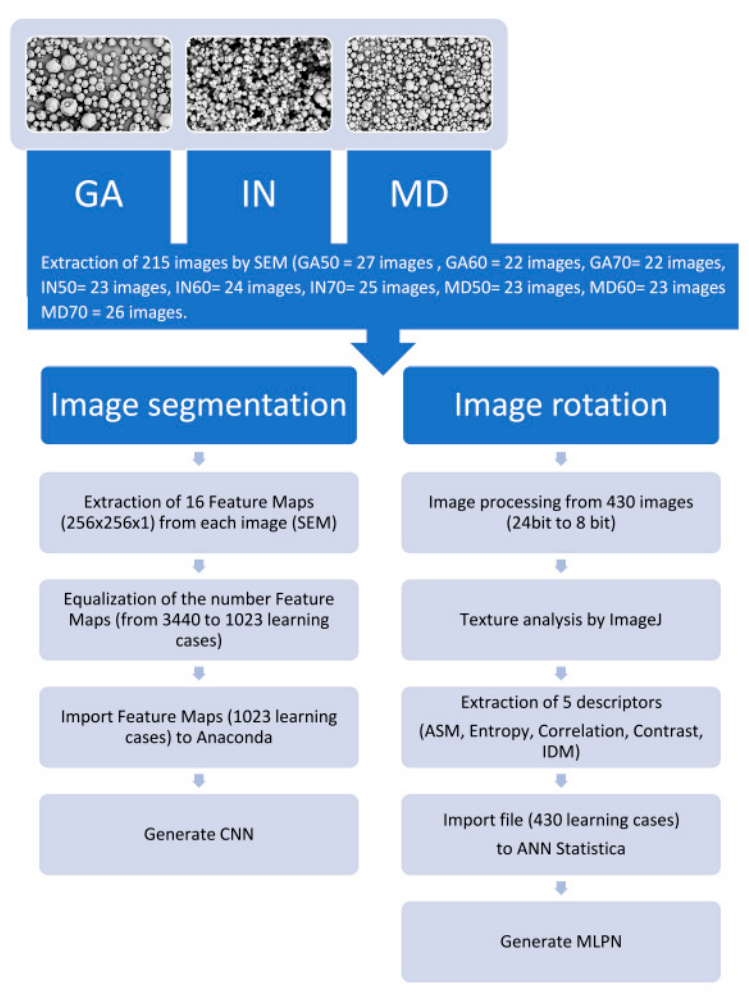
Figure 1. Scheme of image processing.